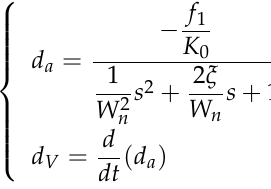
Table 3. Parameters of the landing gear lateral stiffness model.